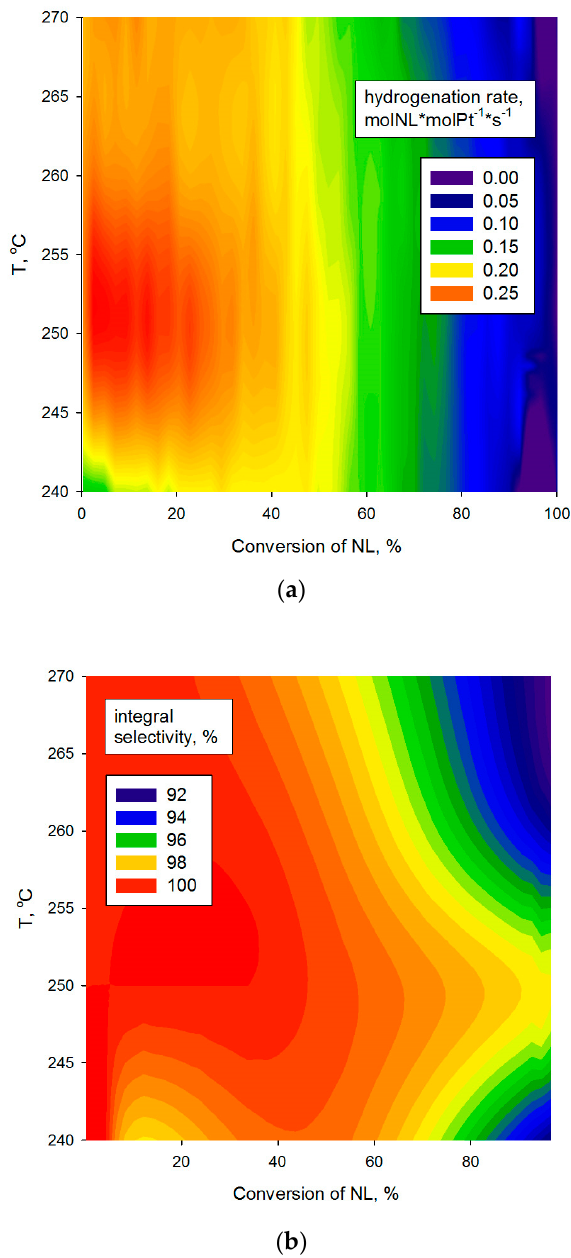
Figure 3. Diagrams of specific instantaneous reaction rate ( a ) and of integral selectivity with respect to TL ( b ) as a function of both NL conversion and temperature (1.5 g of NL, 0.1 g of catalyst, 40mL of hexane, 6 MPa).